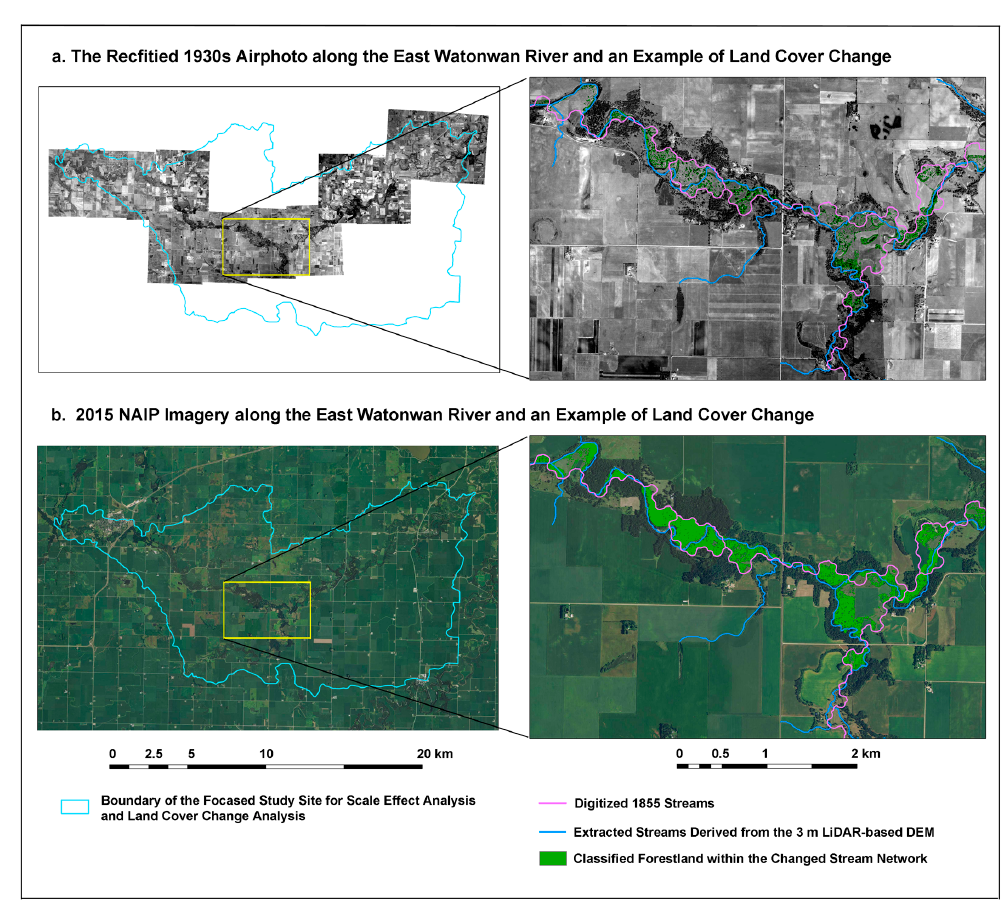
Figure 7. Land-cover change within the changed stream network in the 1930s historical aerial photos and 2015 National Agricultural Inventory Program (NAIP) imagery along the east Watonwan